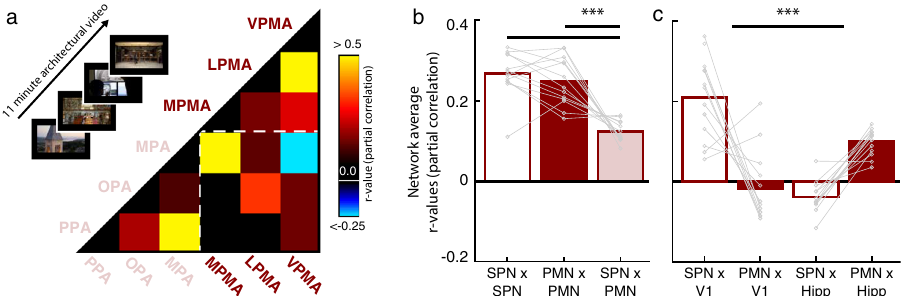
Fig. 4 The place-memory areas constitute a distinct function network and associate closely with the hippocampus. a Experiment 2. To assess whether the place-memory areas and scene-perception areas form distinct functional networks, participants watched an 11-minute video designed to elicit naturalistic scene understanding, comprised of several college admissions videos, real-estate listings, and architectural tours. For each participant ( n = 13), the average time series from the scene-perception areas (pink, parahippocampal place area [PPA], occipital place area [OPA], and medial place area [MPA], the place-memory areas (burgundy, medial, ventral, and lateral place-memory areas [MPMA, LPMA, VPMA]), and the pairwise partial correlation was calculated. The correlation matrix depicts the average partial correlation of each area from all participants (ordered by Ward similarity). b The average pairwise partial correlation of within-network activity (Scene-perception network × Scene-perception network [SPN × SPN] and place-memory network × place-memory network [PMN × PMN]) was signi fi cantly higher than the correlation of between network activity (SPN × PMN) ( F (2,60) = 50.915, p < 0.001). c The scene-perception and place-memory areas differentially associate with the brain ’ s visual and memory systems ( F (3,84) = 55.5, p < 0.001). The scene-perception areas were more correlated with early visual cortex ( t 12 = 6.05, p < 0.001), while the place-memory areas were more correlated with the hippocampus ( t 12 = 10.64, p < 0.001), which is further evidence for their roles in perception and memory, respectively. In all plots, n.s., p > 0.05; * p < 0.05; ** p < 0.01; *** p <